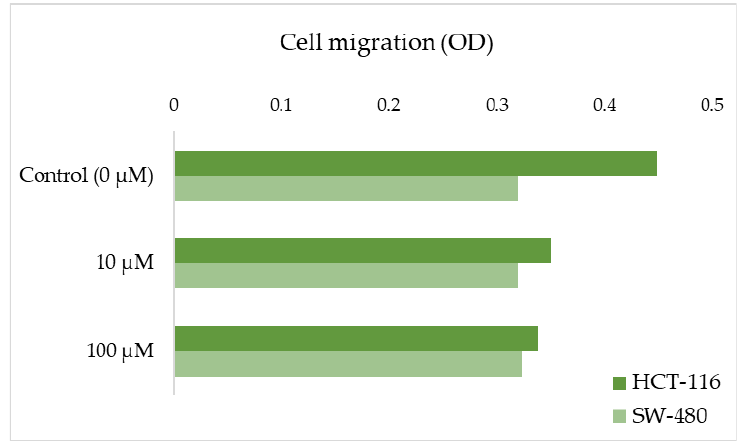
Figure 2. Effects of 10H2DA on HCT-116 and SW-480 cells motility, 24 h after treatment.